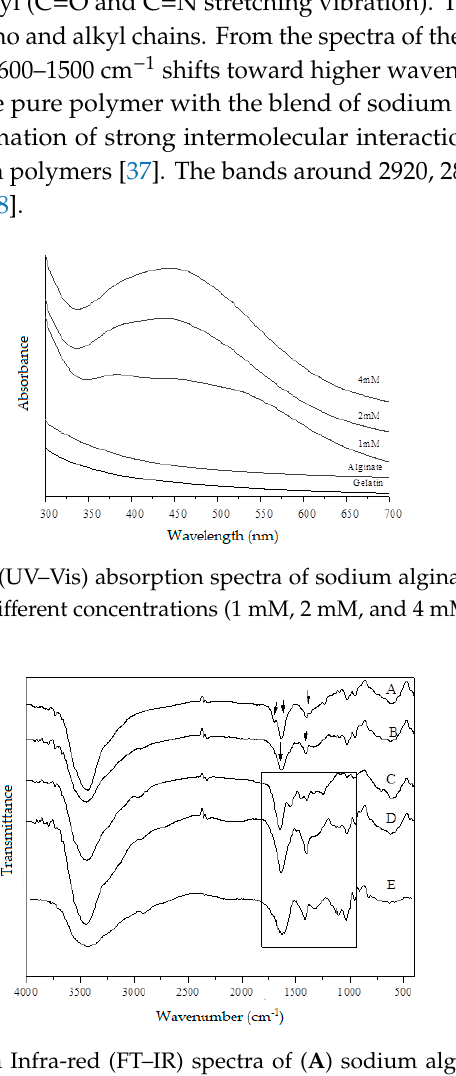
Figure 2. Fourier Transform Infra-red (FT–IR) spectra of ( A ) sodium alginate, ( B ) gelatin, and of hydrogels with silver nanoparticles at different concentrations ( C ) 1 mM, ( D ) 2 mM, and ( E ) 4 mM. Arrows of spectrum A correspond to the bands around 1650 cm − 1 (C=C stretching), 1250 cm − 1 (C–O–C stretching); arrows of spectrum B correspond to 1640 cm − 1 and 1510 cm − 1 of amide carbonyl (C=O and C=N stretching vibration); spectra of the hydrogel (square of C, D, and E) are the bands around 1600–1500 cm − 1